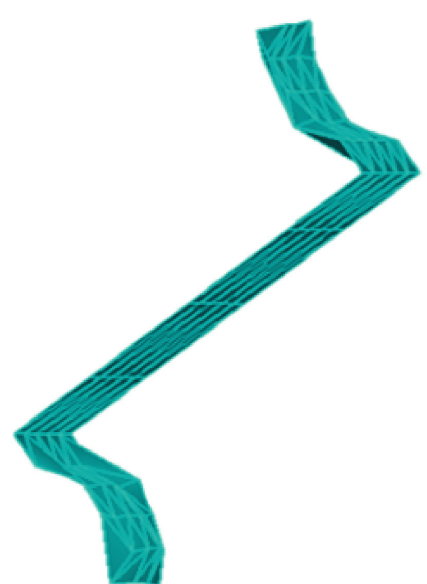
Figure 12: Crack propagation under uniaxial